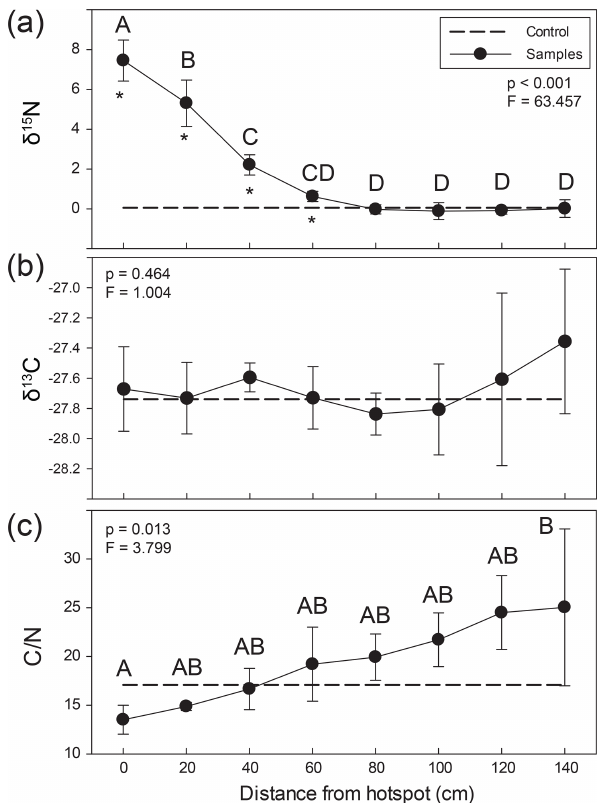
Figure 3. Lateral changes in soil stable (a) δ 15 N and (b) δ 13 C isotopic composition and (c) C / N ratios extending from carrion hotspot centers. Soil was visibly discolored 35–40cm from the cen- ter (here, 0cm distance). Letters indicate soil samples taken at dis- crete distances from hotspot center that were not significantly dif- ferent based on an ANOVA and Holm–Sidak post hoc test. Aster- isks denote the significant differences between control and hotspot soils ( t test) at each respective distance. The dashed line represents control surface soil (0–5cm) composition.